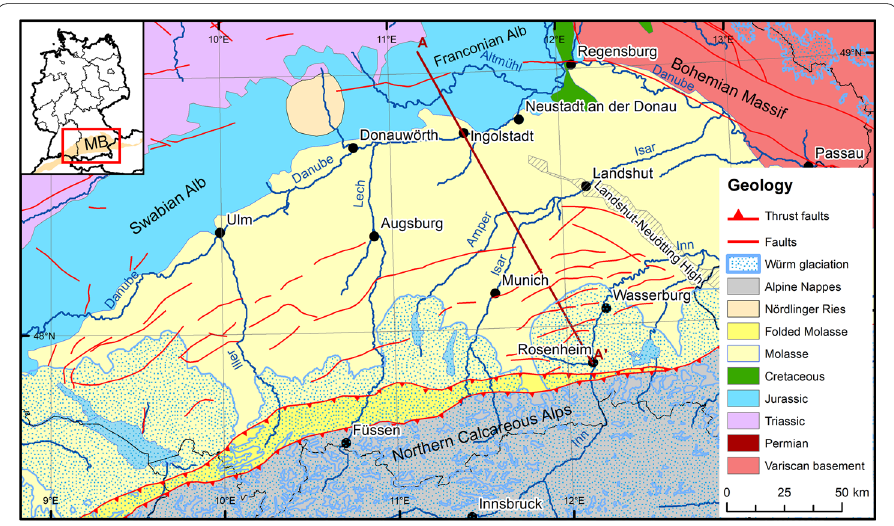
Fig. 1 Regional geological map of the Southern German Molasse Basin, modified after Bousquet et al. (2012) and Doben et al. (1996). Maximum extent of the Würm Glaciation according to digital maps by Gibbard et al. (2011). Dark red line AA’ indicates the studied cross section. Inset map shows the location of the map in Germany (MB Molasse =